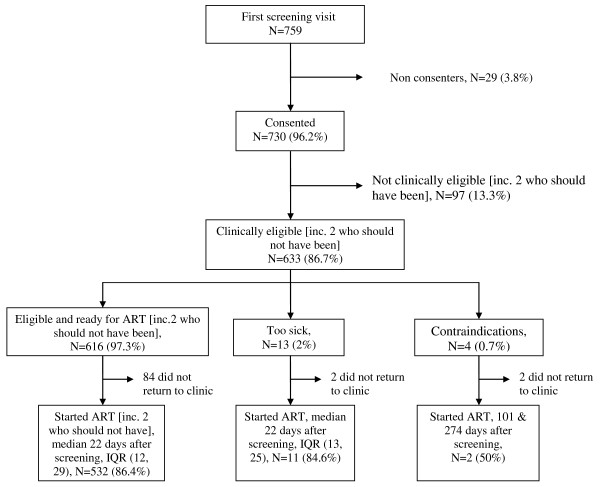
Outcome of first screening visit and ART initiation status.